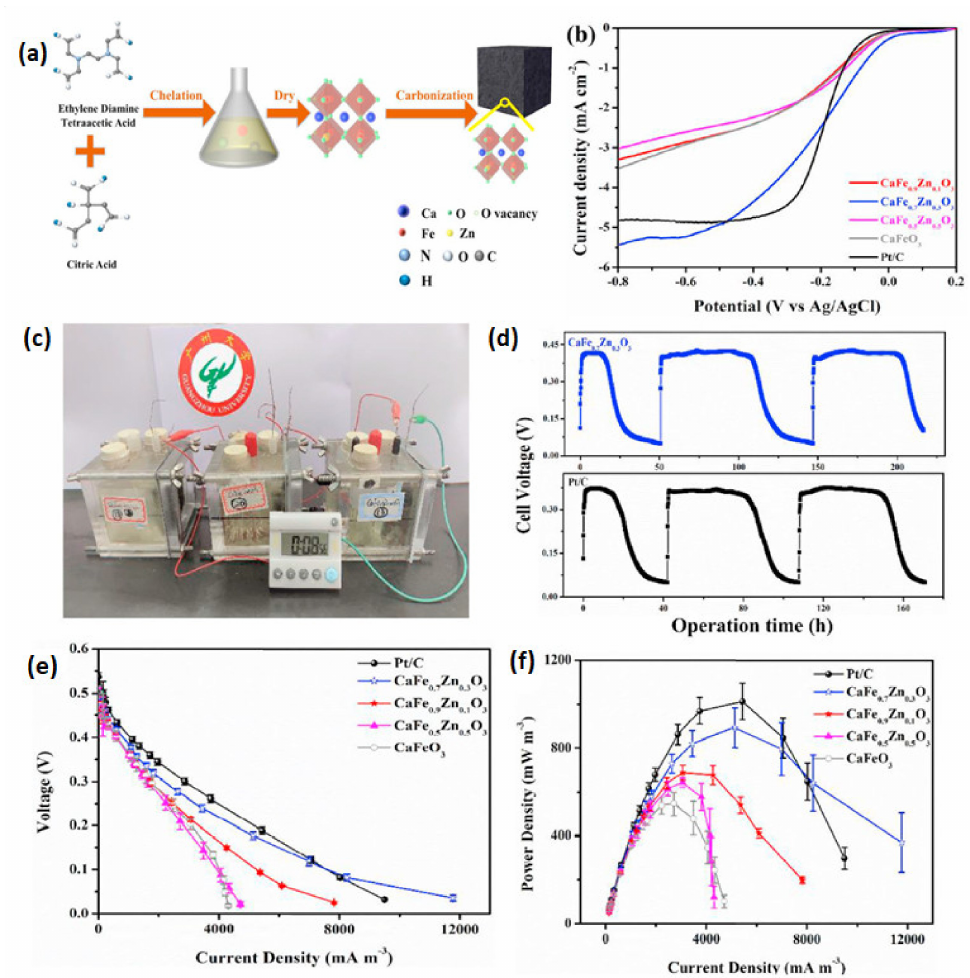
Figure 5. ( a ) The fabrication process of CaFe x Zn (1-x) O 3 catalysts; ( b ) electron transfer number and H 2 O 2 yield of CaFe 0.7 Zn 0.3 O 3 ; ( c ) simulated operation of MFCs; ( d ) output voltage of CaFe 0.7 Zn 0.3 O 3 and Pt/C; ( e ) polarization curves; ( f ) power density of CaFe 0.7 Zn 0.3 O 3 and Pt/C. (Reprinted with permission from [52]. Copyright 2021,